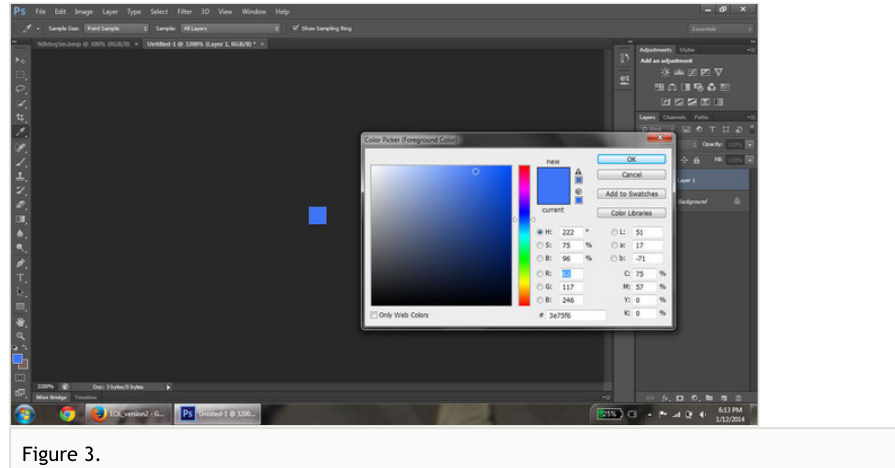
Figure 3. Selected area has been resized to 1 pixel; color picker tool shows the RGB values of the